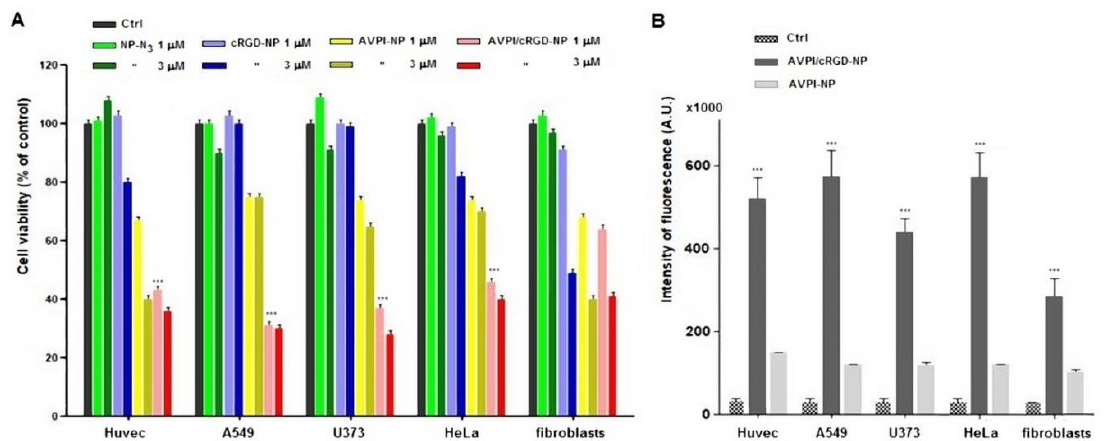
Figure 2. ( A ) Cell viability of peptide–NPs as % of control cells. Bars represent the mean ± SD from two independent experiments (n = 2), each performed in triple. ( B ) Caspase-9 levels after 6 h of incubation with either 1 µM AVPI/cRGD–NPs or AVPI–NPs. Bars indicate the increase in activity of the treated cells compared to the control. Data are reported as mean ± SD from at least three independent experiments. *** p < 0.001.